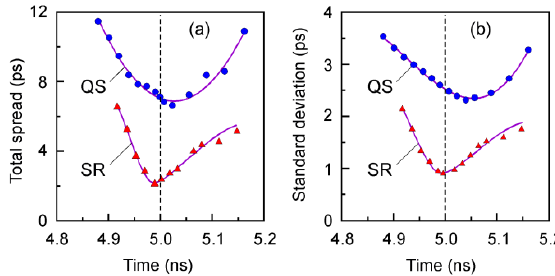
Fig. 2. Total phase spread (a) and corresponding standard devia- tion (b) for rf pulses of QS BWO and SR BWO depicted in Fig. 1 (c). Period of microwave oscillations is ~34 ps. Time “5 ns” corresponds to the maximum of time derivative of the voltage pulse front in Fig. 1